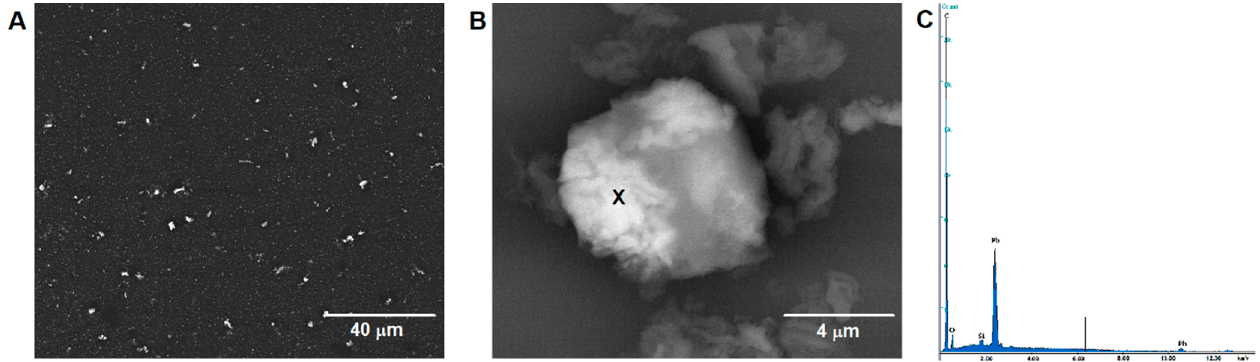
Figure 7. SEM images of Pb ‐ N ‐ CMK ‐ 3/GCE ( A , B ). ( C ) The EDS spectrum of the highlighted fragment of Pb ‐ N ‐ CMK ‐ 3/GCE.